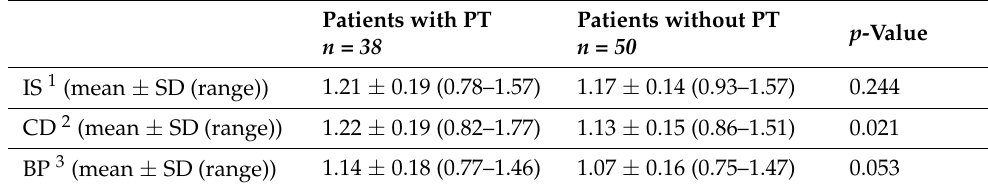
Table 2. Comparison of patellar height on MRI.